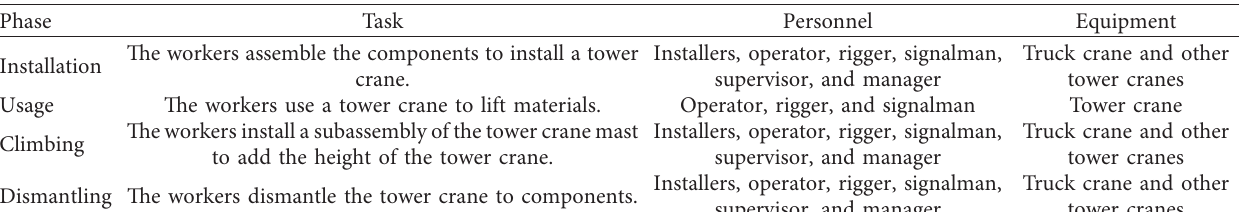
Table 2: Features of tower crane